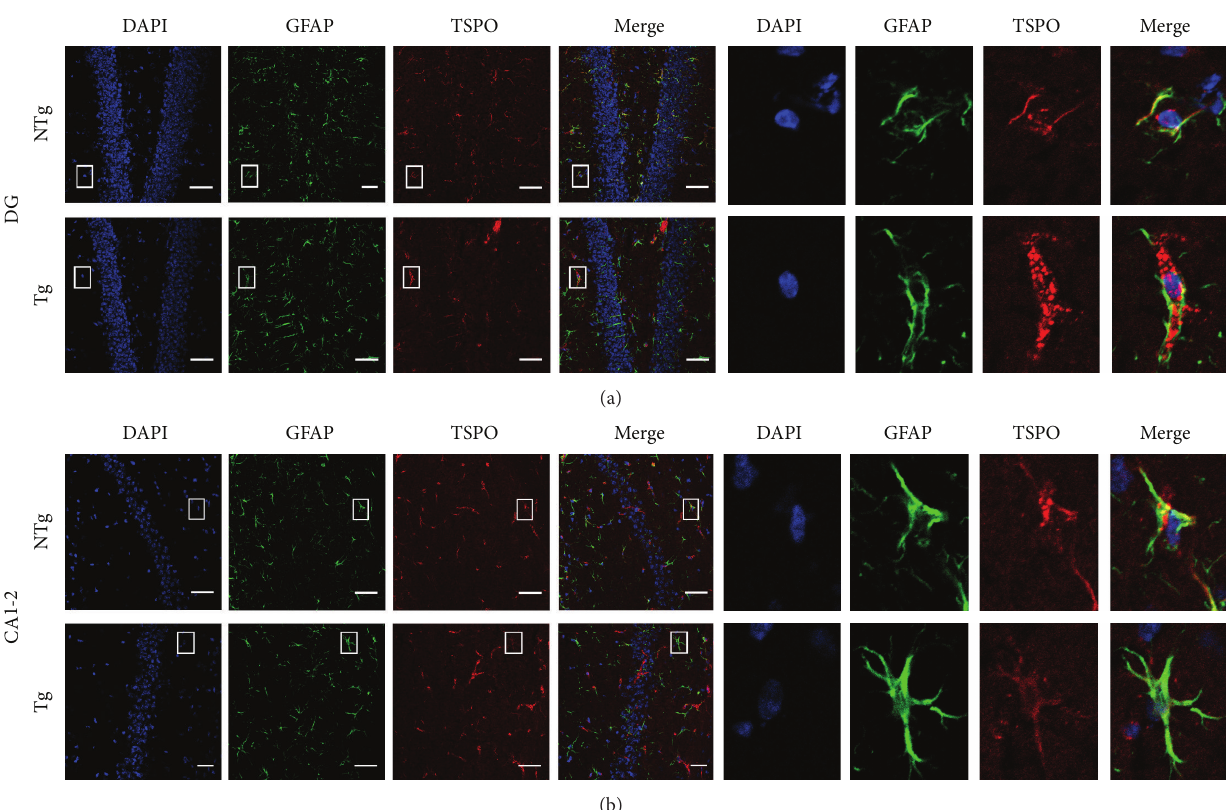
Figure 4: Immunofluorescence of GFAP/TSPO colocalization in hippocampal subregions of WT and APPswe/PS1dE9 mice at 3 months. Confocal staining of DAPI for nuclei (blue), GFAP for astrocytes (green), and TSPO (red) in DG (a) and CA1-2 (b) in WT (upper) and APPswe/PS1dE9 (lower) mice. A white square represents a magnified region of interest. Scale bar: 50 𝜇 m.